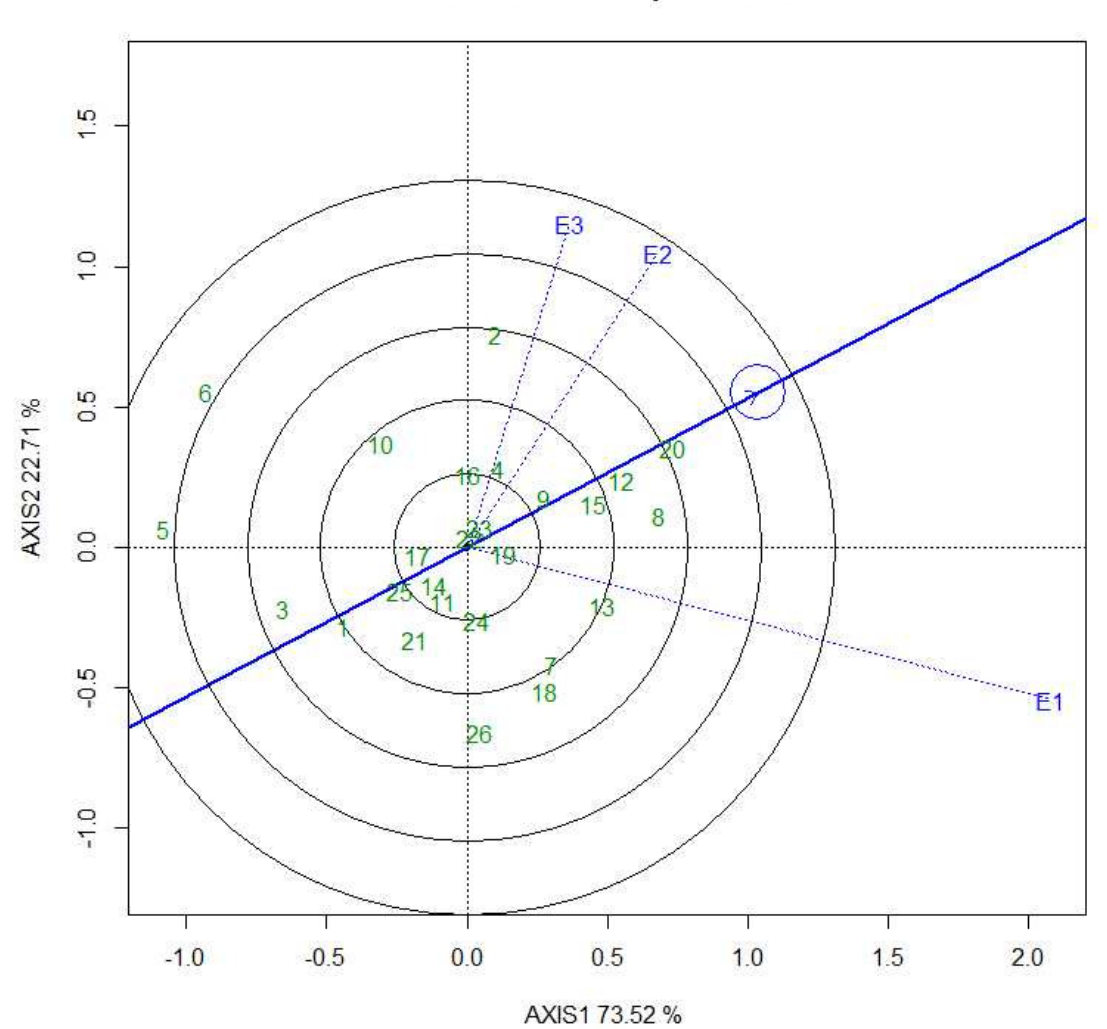
Figure 6. The vector view of the GGE biplot of 26 rice hybrid combinations in three locations for grain yield.